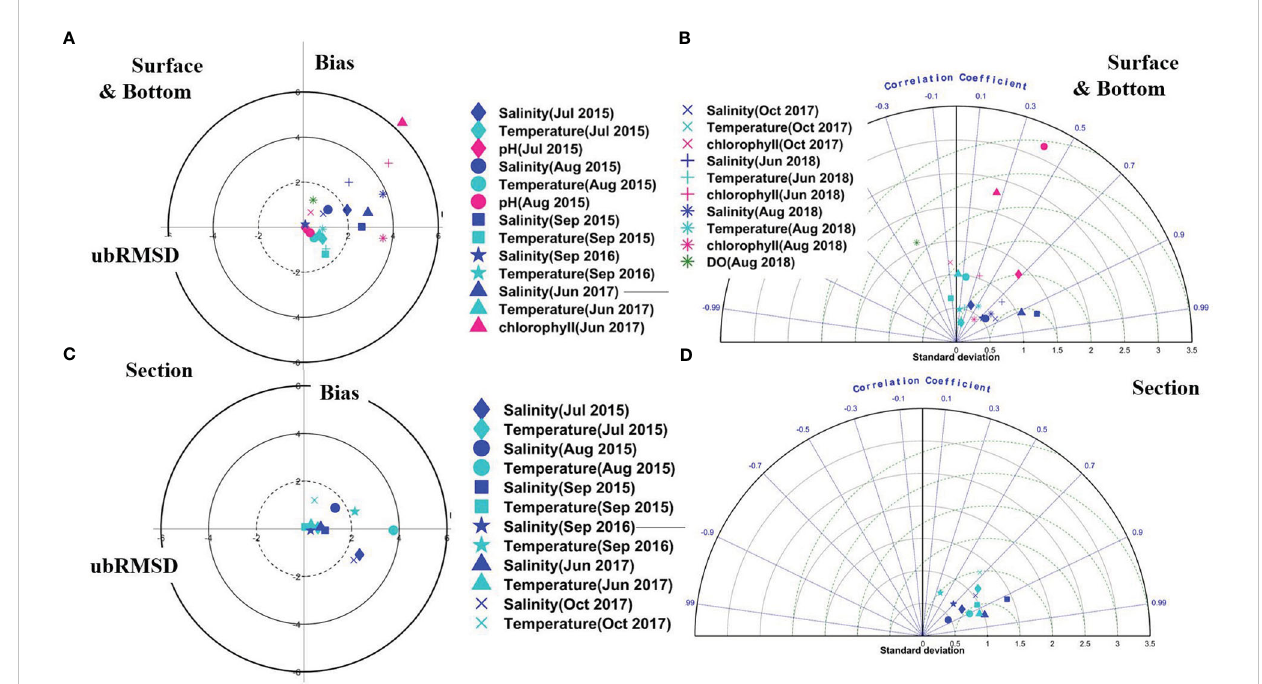
FIGURE 8 Target and Taylor diagrams displaying model skills for multiple hindicast variables between 2015 to 2017 individually on surface and bottom (A, B) and Sections (C, D) . Each marker shape represents a different